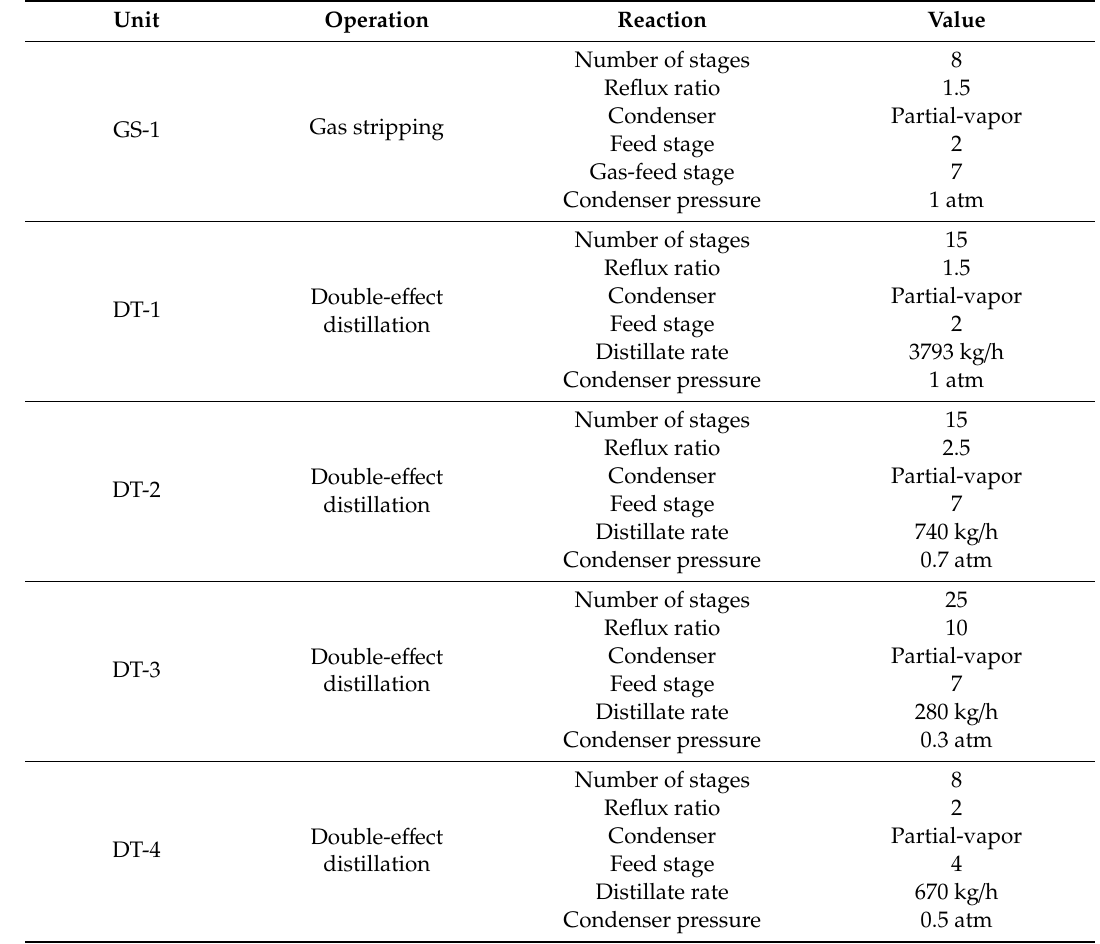
Table 3. Summary of the technical parameters of the main separation units in topology